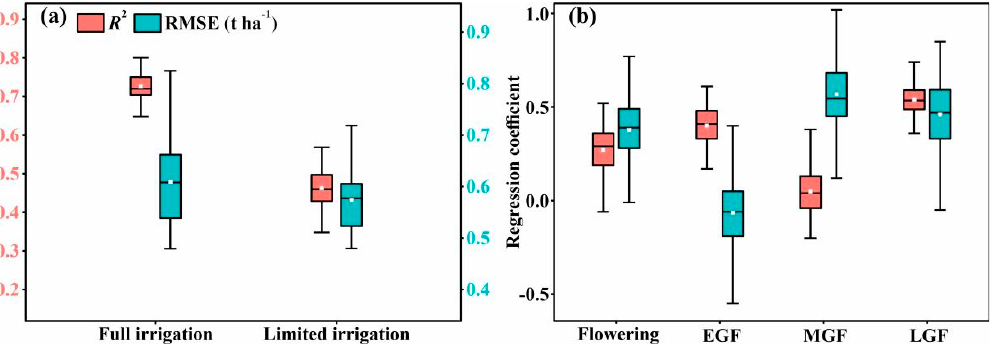
Figure 7. ( a ) Statistical distributions of R 2 and RMSE of stacking four growth stages for predicting grain yield, and ( b ) the distribution of regression coefficients within the level-2 model. Abbreviations: EGF, early grain fill; MGF, mid grain fill; LGF, late grain fill.